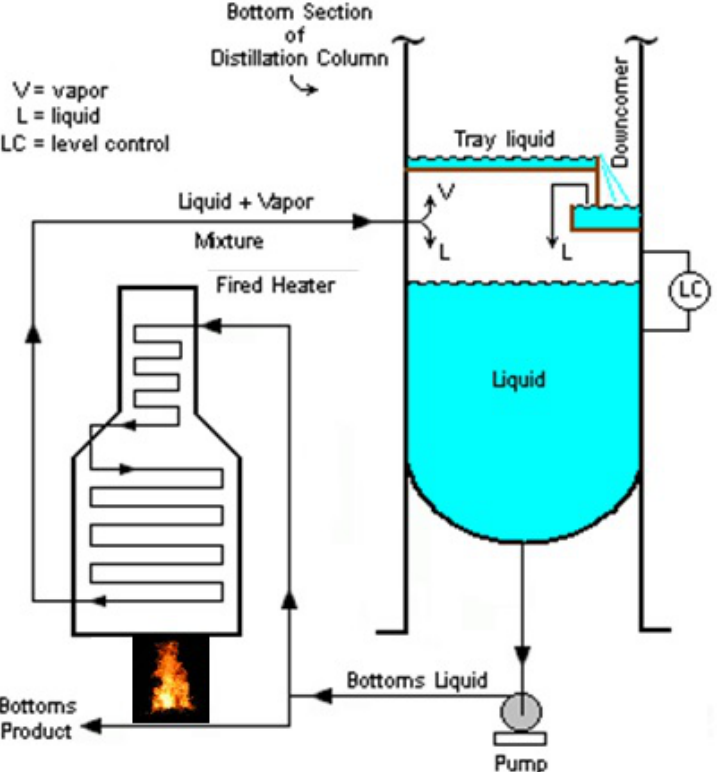
Figure 2. Schematics of forced recirculating fired heater reboiler.